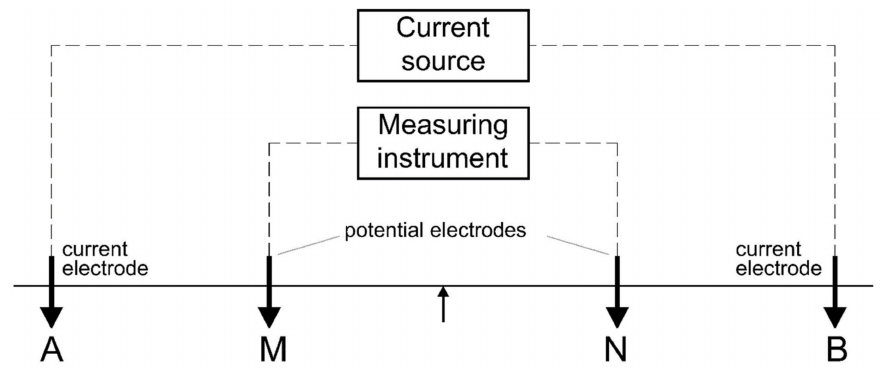
Figure 4. Diagram of the basic measurement in the electrical resistivity